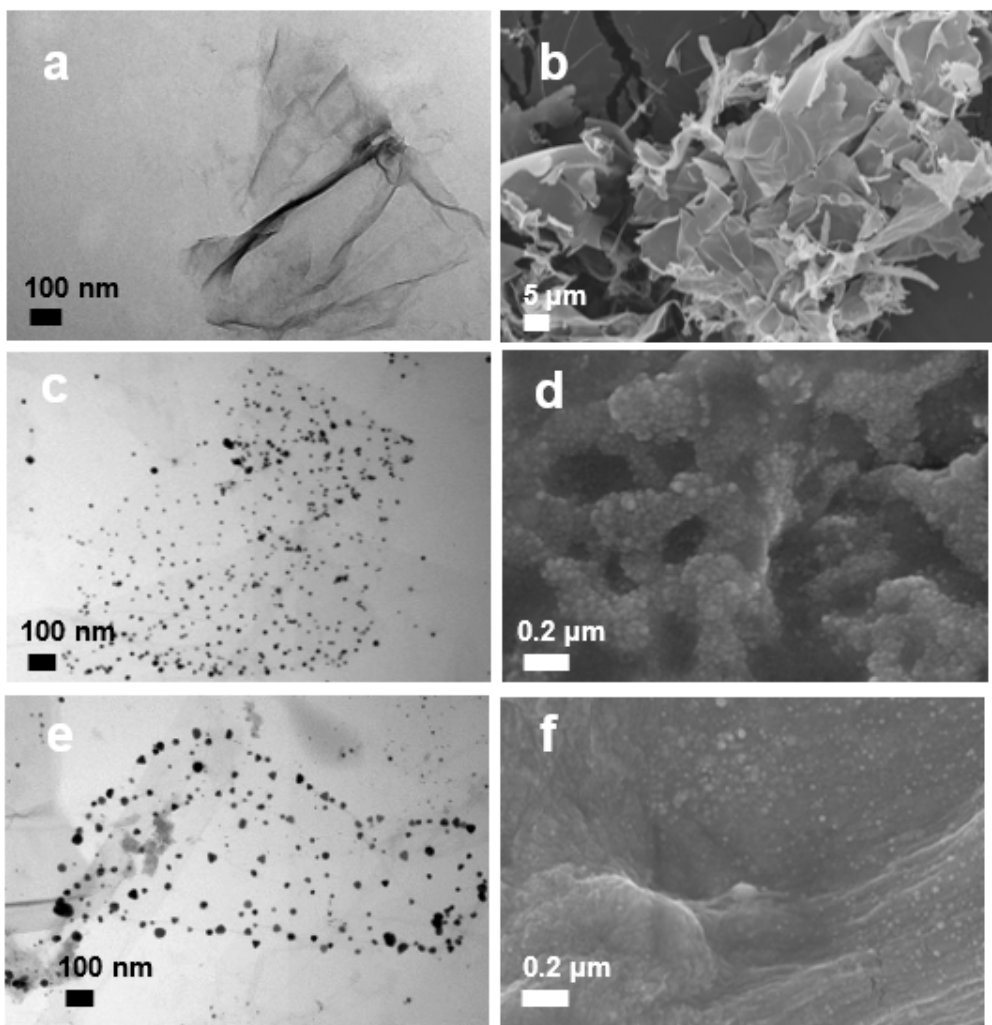
Figure 3. TEM and FESEM images of GO ( a , b ), GO–Ag NPs ( c , d ) and GO–Ag NPrsms ( e , f ), respec-